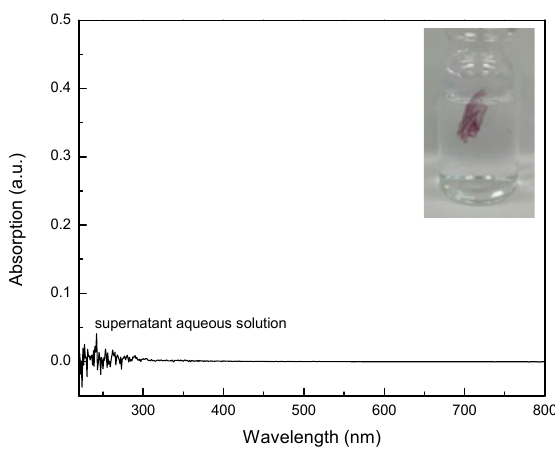
Figure 6. UV-vis spectrum of the supernatant aqueous solution recorded after immersing the crosslinked PVP/Au electrospun fibrous mat in water at ambient temperature for several days. The resulting materials were also visualized by TEM to obtain information on the size and morphological characteristics of the Au NPs embedded within the polymer fibers. Figure 7 depicts